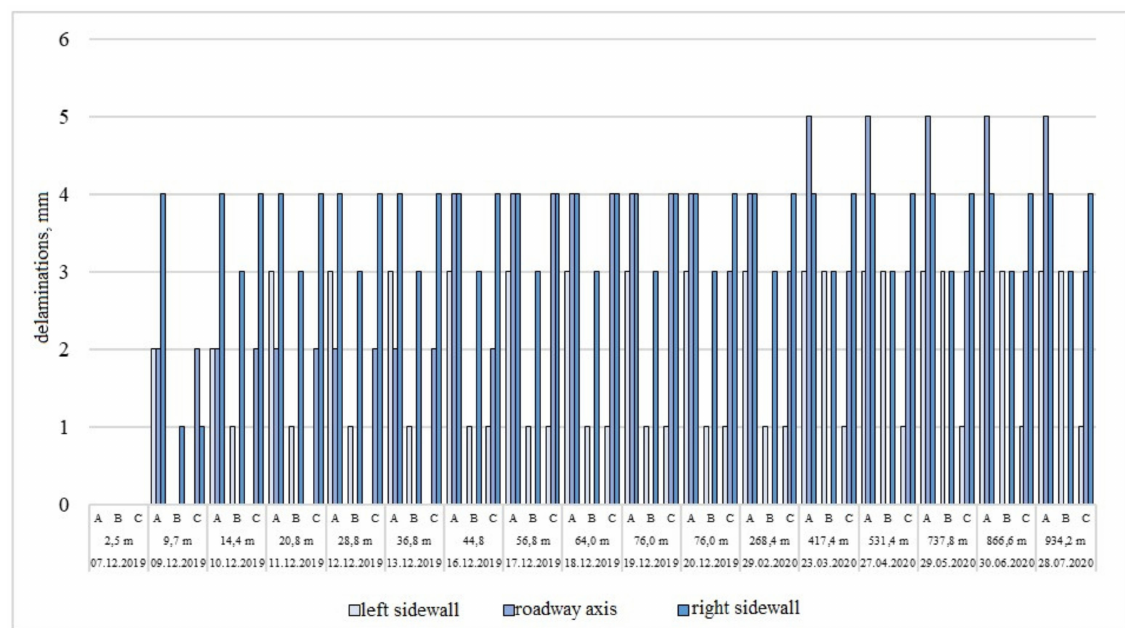
Figure 5. Roof delaminations’ values measured on the periodic control station no. 2.